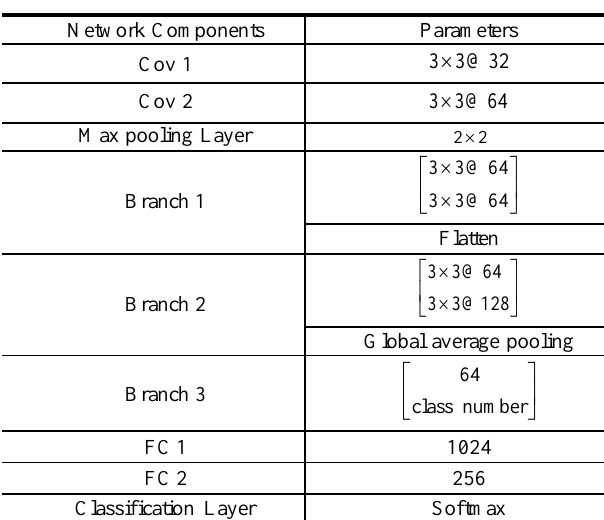
Table 2. DGCNet model parameters, where Cov denotes convolutional layer, FC denotes fully connected layer.